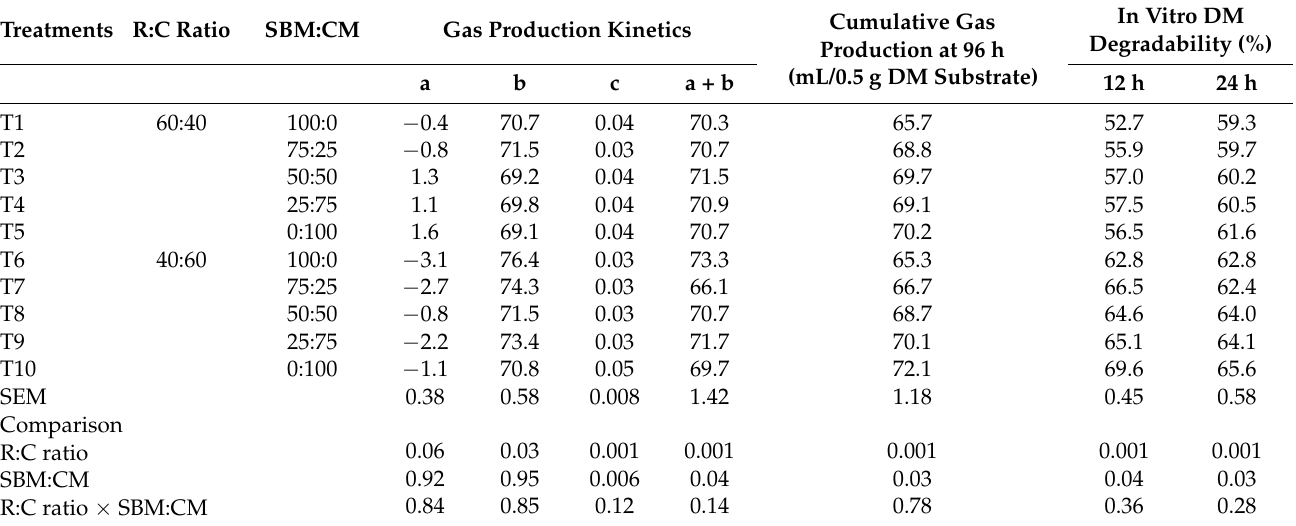
Table 2. Effect of cricket meal ( Gryllus bimaculatus ) (CM) on gas production kinetics and in vitro DM